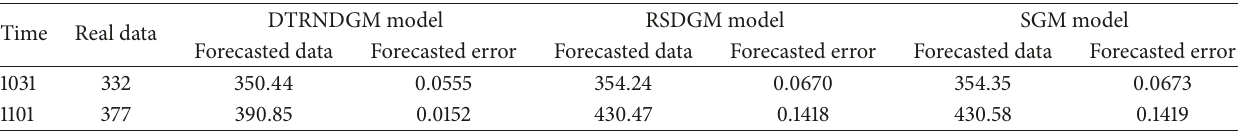
Table 5: Simulated or forecasted values and errors of traffic flow with the 𝜒 ∈ 𝑅 3×7×24×4 model.